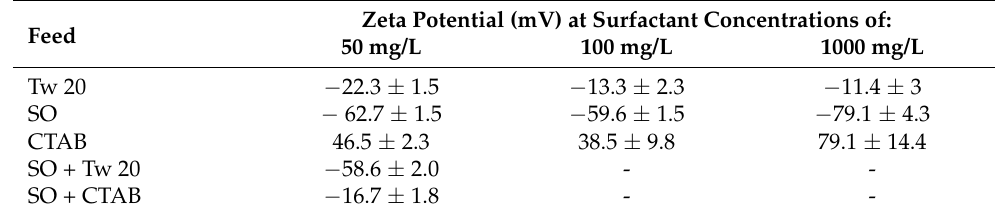
Table 3. Zeta potential of different feed